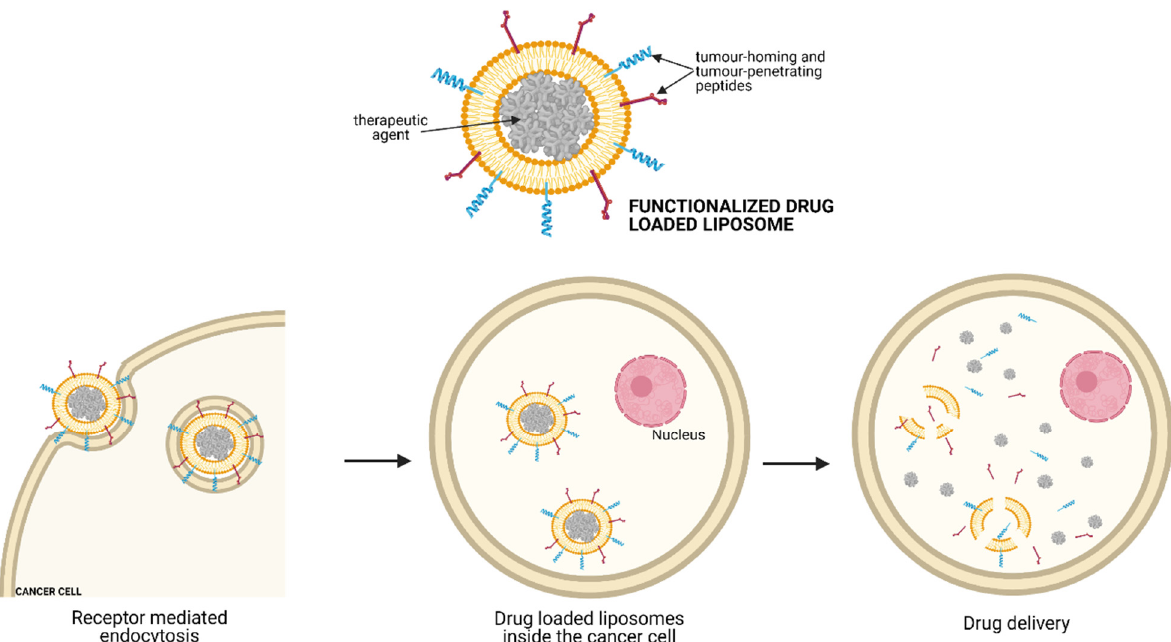
Figure 2. Mechanism of action of drug-loaded liposomes. Liposomes are loaded with anticancer agents and functionalised with peptides capable of recognising the cell of interest. Once the liposome fuses its lipid bilayers with other cell bilayers, the anticancer drugs are released from the liposome into the cancer cells, exhibiting their cytotoxic action.